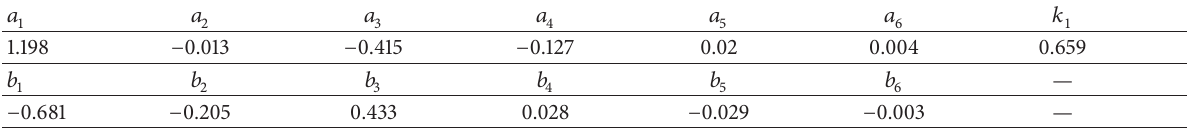
Table 1: Parameters of the used TDD model.